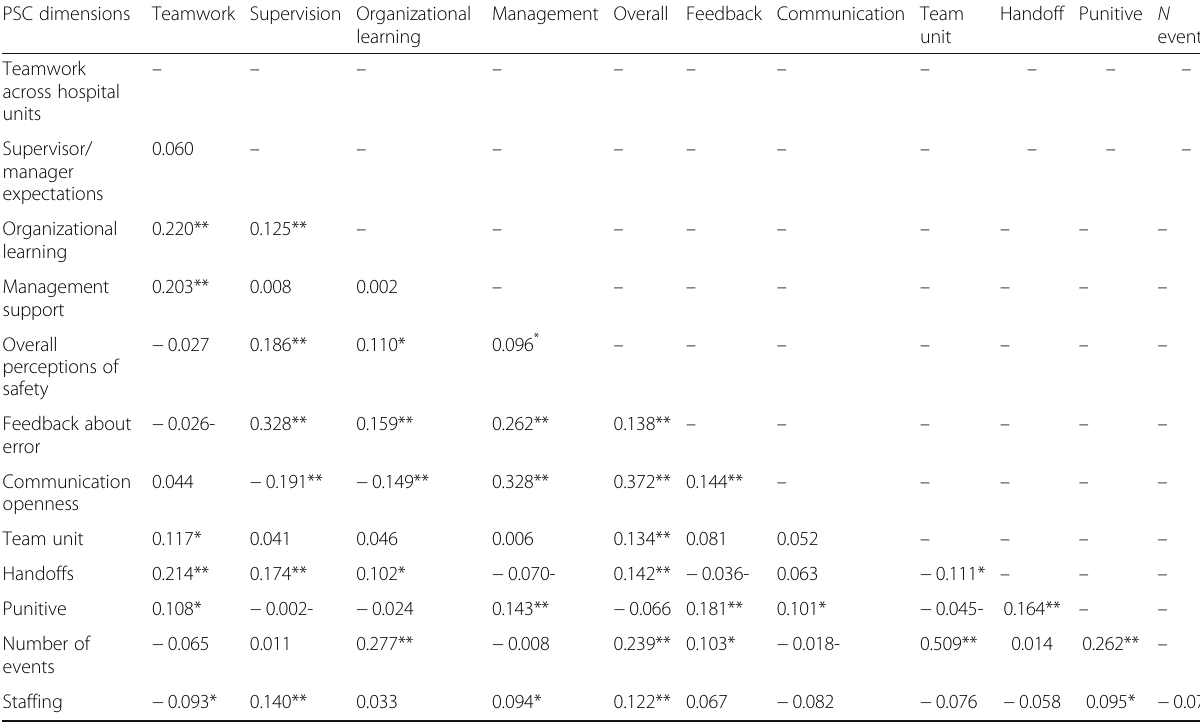
Table 4 Correlation between patient safety culture dimension